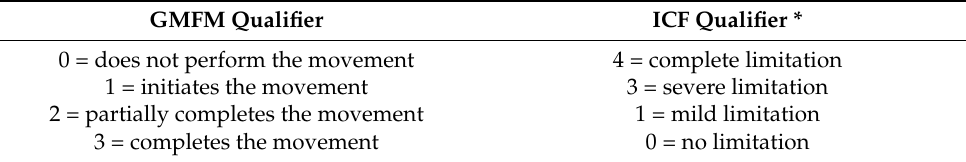
Table 1. Correlation between GMFM Qualifiers and